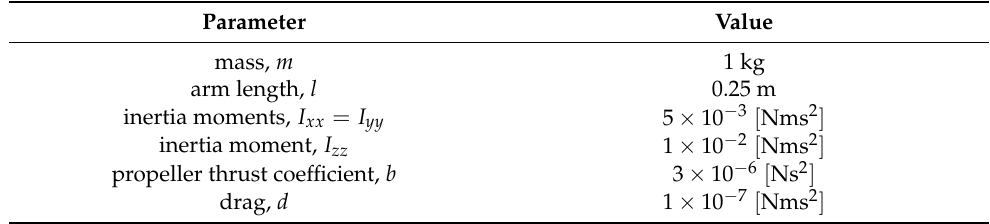
Table 1. Quadrotor dynamic parameters.